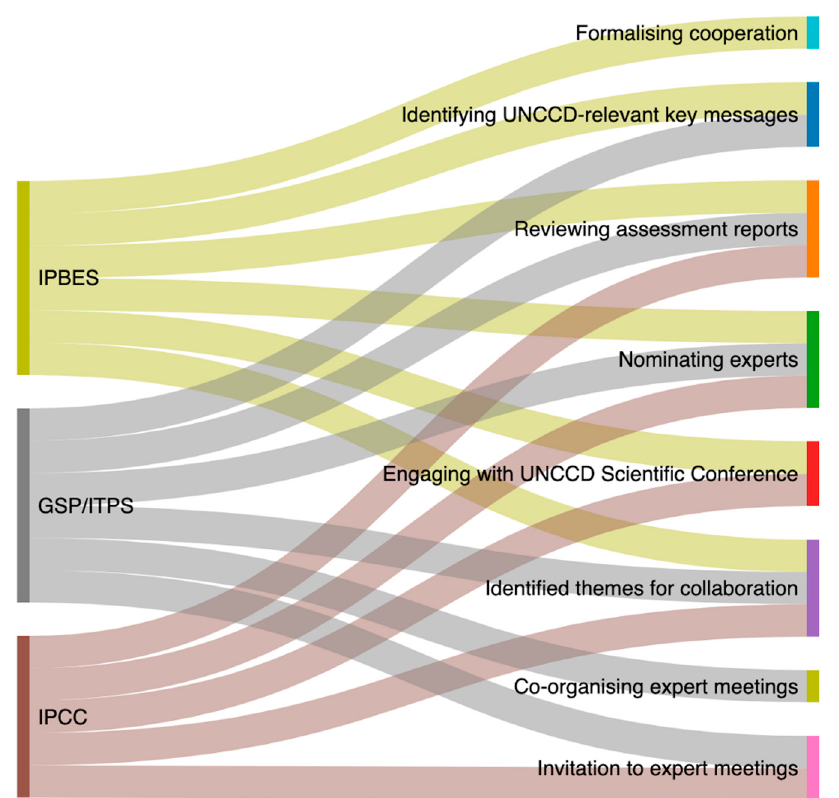
Figure 3. As part of its coordination activities, SPI collaborated with IPBES, IPCC, and GSP/ITPS